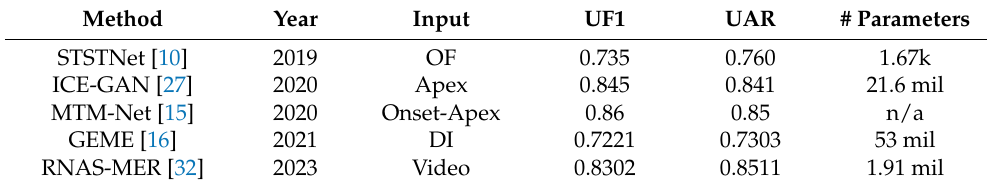
Table 3. Baseline methods on MEGC 2019 composite dataset. OF: Optical Flow. DI: Dynamic